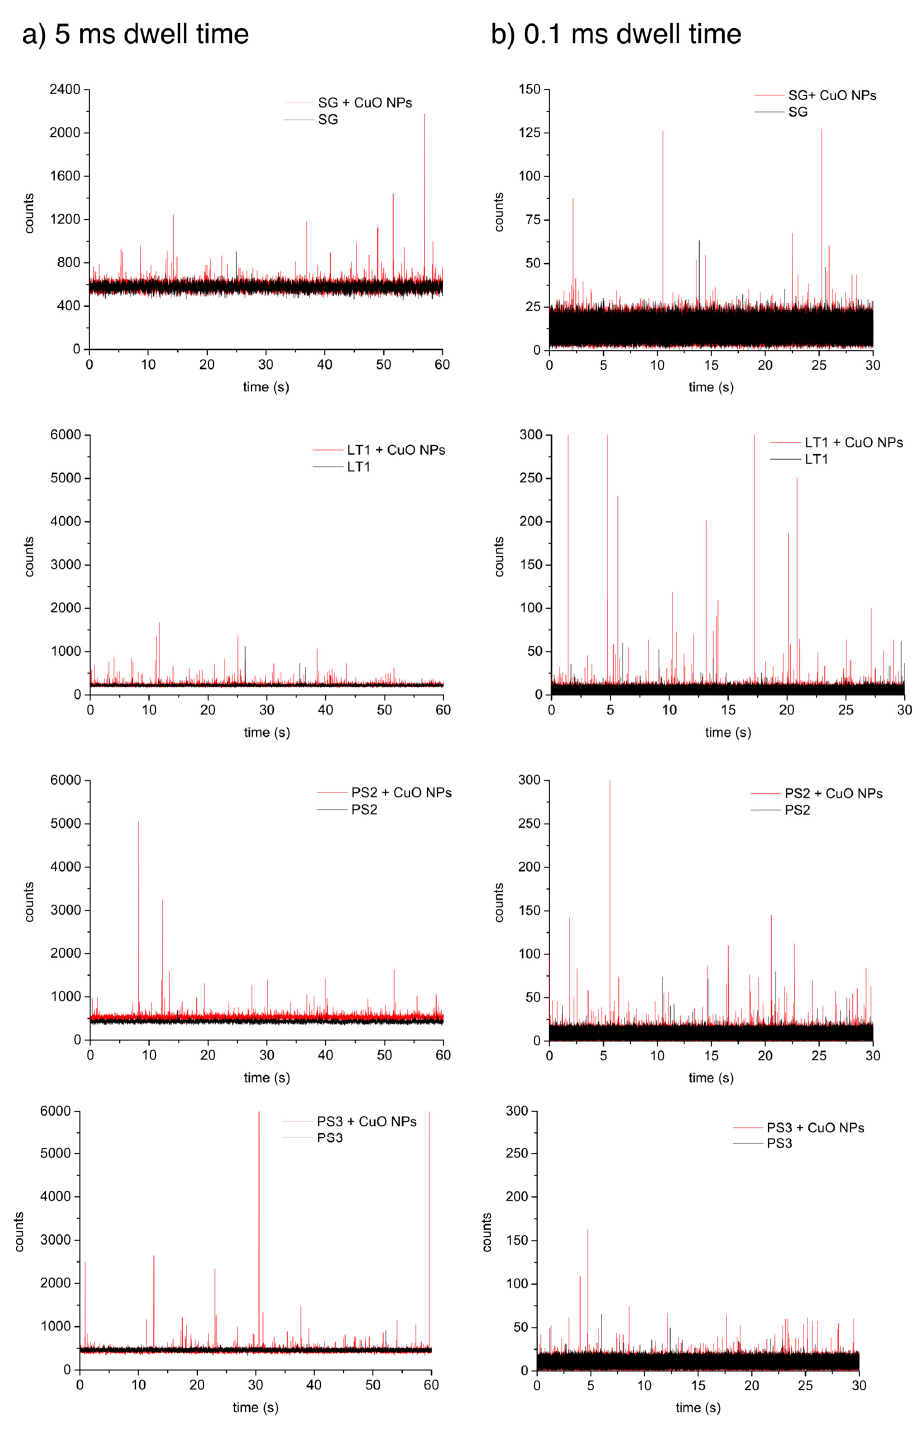
Figure 2. Raw spICP-MS data of the natural colloidal extracts (black line) and colloidal extracts spiked with engineered nanoparticles (red line) at a dwell time of 5 ms ( a ) and 0.1 ms ( b ).